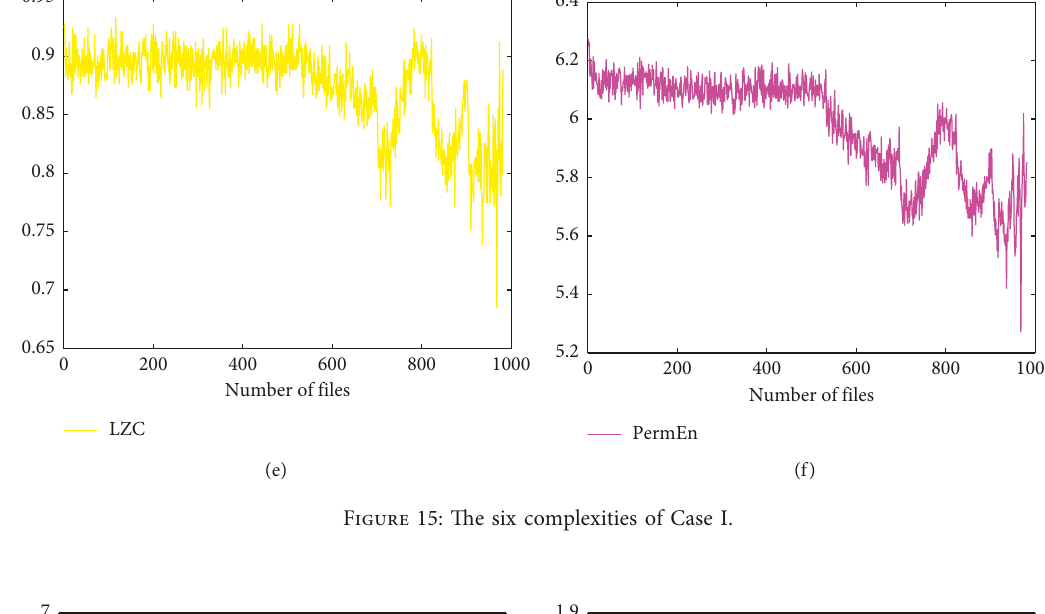
Figure 15: The six complexities of Case I.